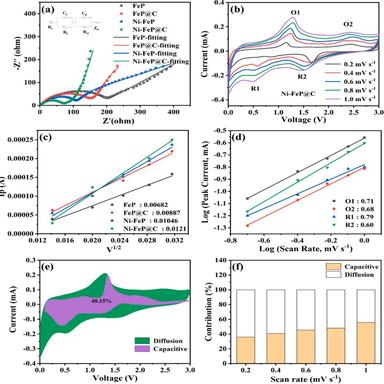
Electrochemical impedance spectra of FeP, FeP@C, Ni-FeP and Ni-FeP@C (a); CV curves of Ni-FeP@C electrode at different scan rates of 0.2–1.0 mV s − 1 (b); Plot of Ip vs. v1/2 according the CV curves of FeP, FeP@C, Ni-FeP and Ni-FeP@C at different scan rates (c); Fitting curves of the b-values of Ni-FeP@C (d); Capacitive contributions under purple shaded areas of Ni-FeP@C electrode at the scanning rate of 0.8 mV s − 1 (e); the contribution ratio of capacitive capacities for Ni-FeP@C electrode at different sc